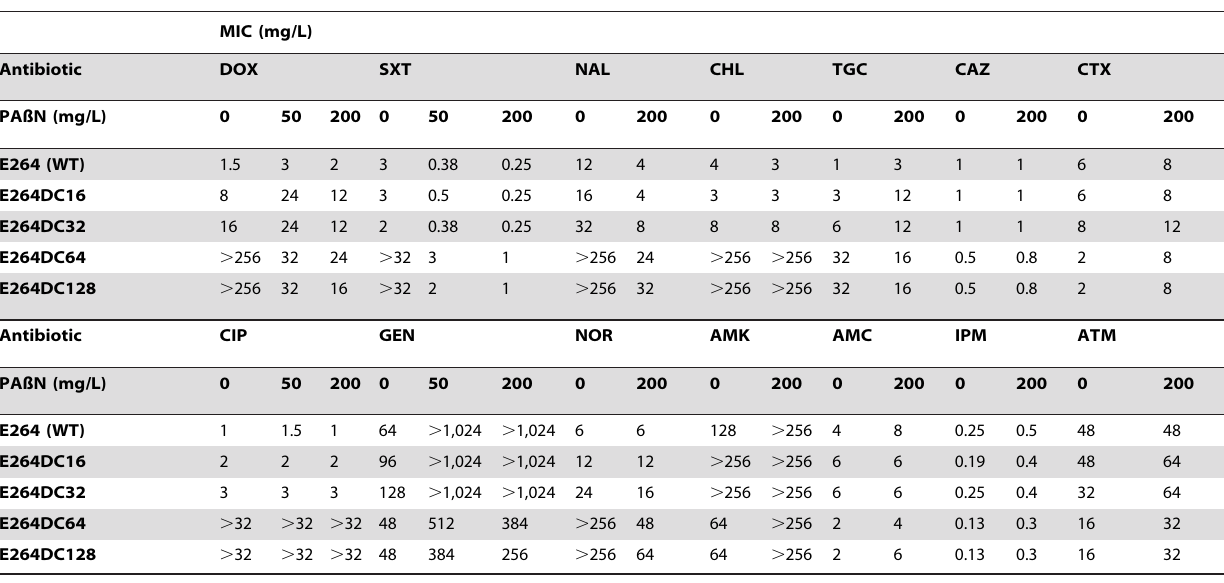
Table 3. Effects of PAßN on the antibiotic susceptibility of B. thailandensis strains.